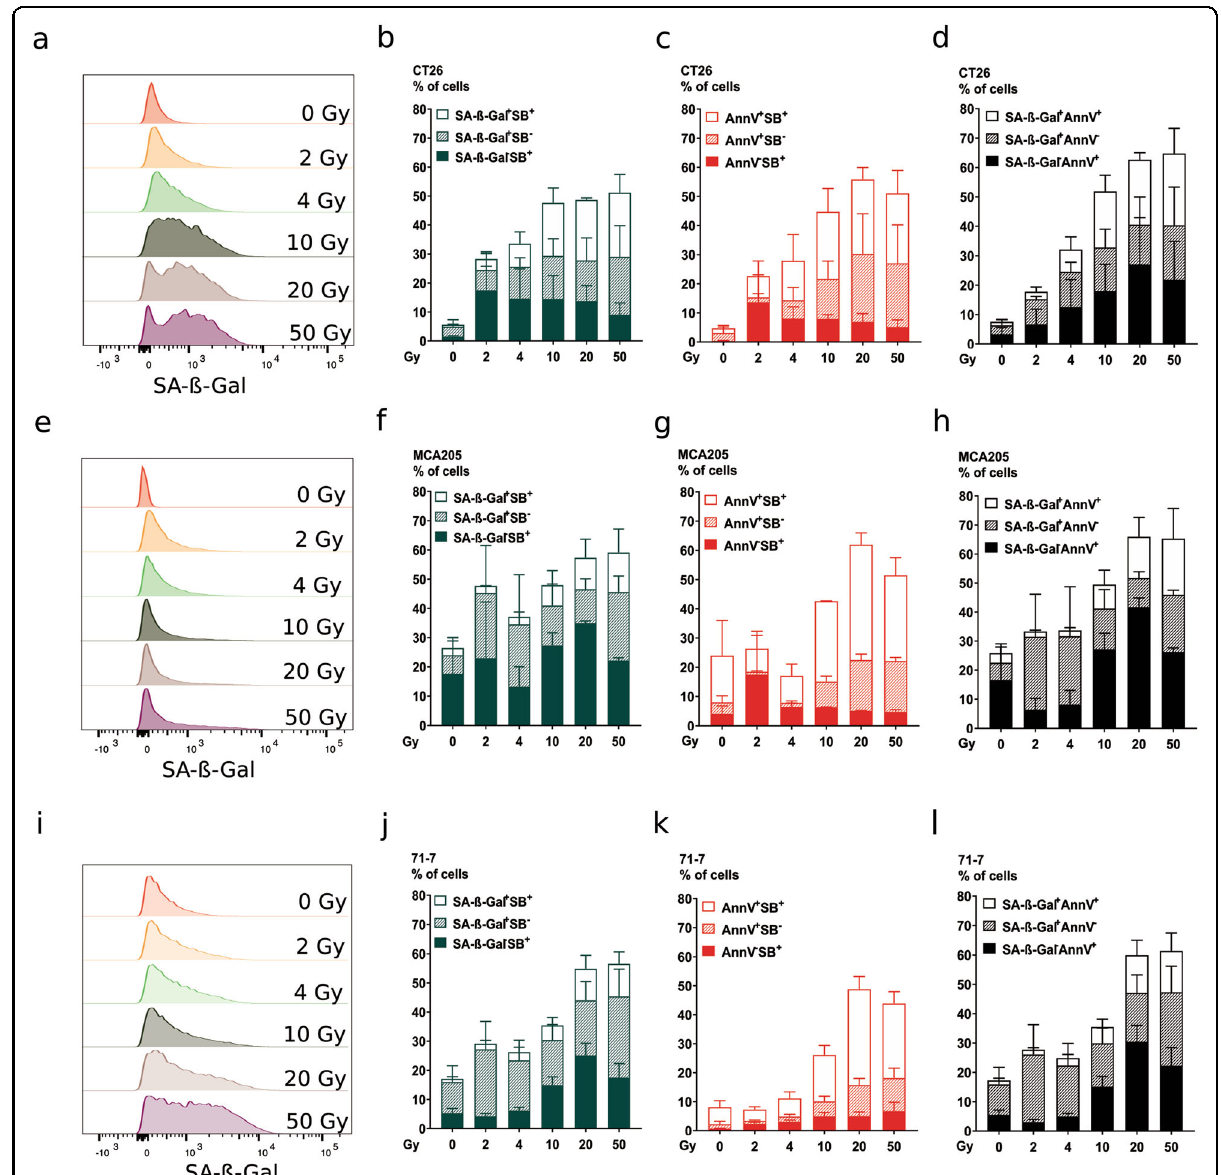
Fig. 5 Ionizing radiation induces senescence. Senescence induction was measured 72 h following irradiation at the indicated doses by fl ow cytometry with C12FDG, a β -galactosidase substrate emitting fl uorescence upon its cleavage. Co-staining with Annexin V-APC and Sytox Blue was performed to indicate apoptosis and membrane permeabilization, respectively, in CT26 ( a – d ), MCA205 ( e – h ), and 71-7 ( i – l ) cells. Representative fl ow cytometry histograms are shown for C12FDG (SA- β -Gal) staining in CT26 ( a ), MCA205 ( e ), and 71-7 ( i ). Percentage of cells positive for C12FDG (SA- β -Gal) and/or Sytox Blue is shown for CT26 ( b ), MCA205 ( f ), and 71-7 ( j ) cells. Percentage of cells positive for Annexin V-APC and/or Sytox Blue